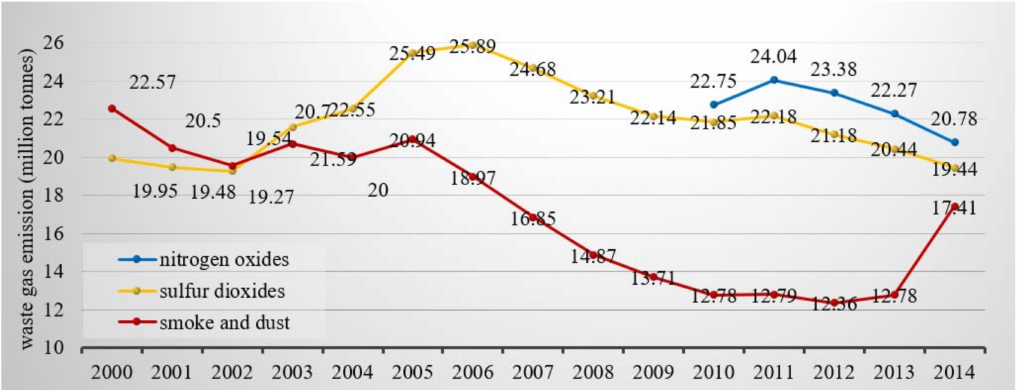
Figure 4. Variations in China’s waste gas emissions (Source: Drafted by authors according to National Environment Statistical Bulletin 2000–2014